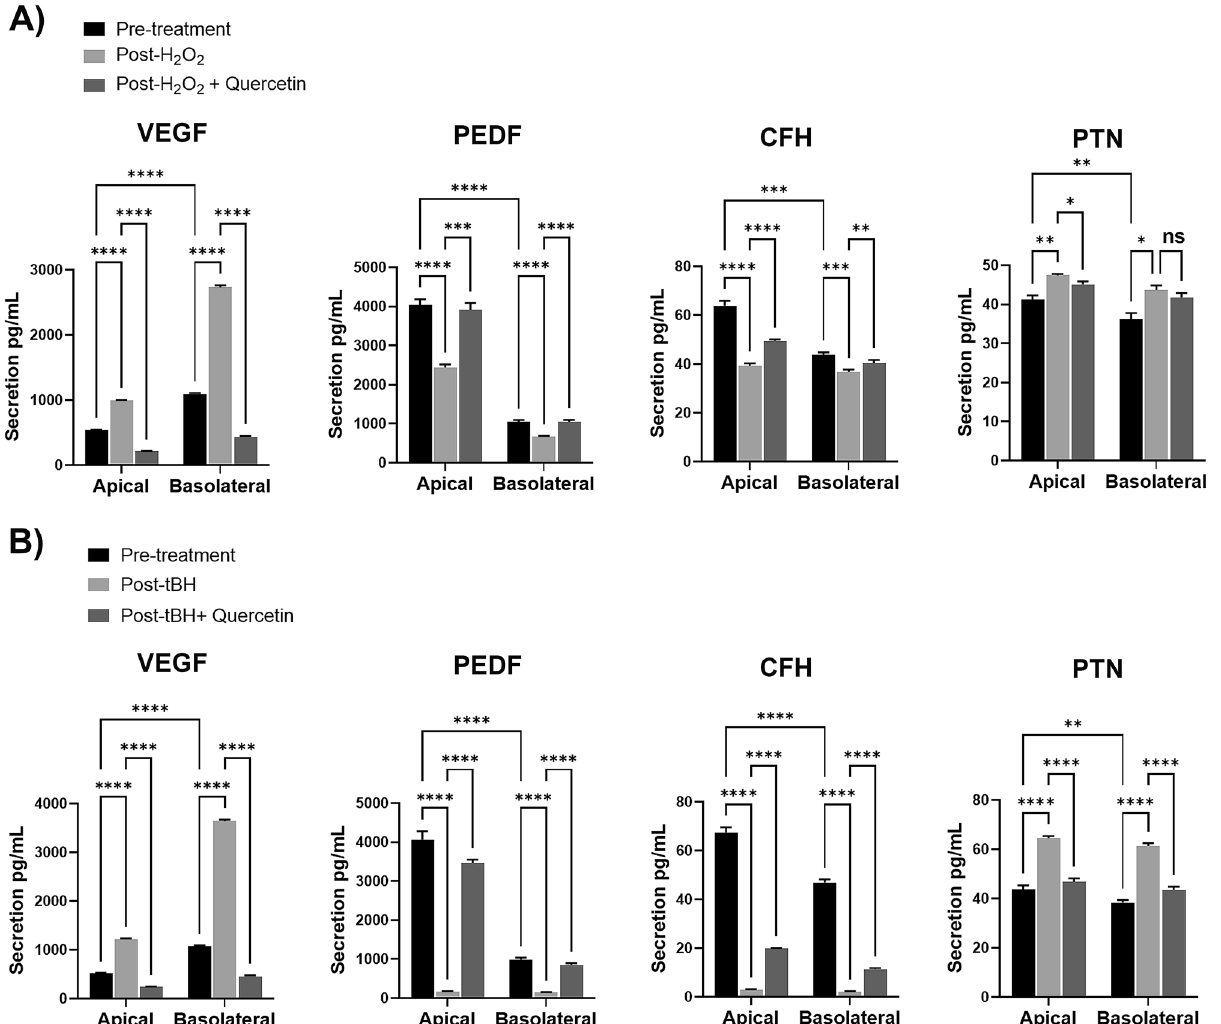
treatment, black) and after incubation with ( A ) 800 µM H 2 O 2 for 24 h (Post-H 2 O 2 , light grey), or ( B ) 1 mM tBH for 6 h (Post-tBH, light grey). Dark grey bars show protective effects of quercetin pre-treatment prior to oxidative stress with H 2 O 2 or tBH. N = 9. Results were analyzed by paired 2-way ANOVA. *p < 0.05, **p < 0.01, ***p < 0.001, ****p < 0.0001, ns = not significant. There was no significant interaction between polarity and treatment effects for PTN, but p-values for post-hoc comparisons are still